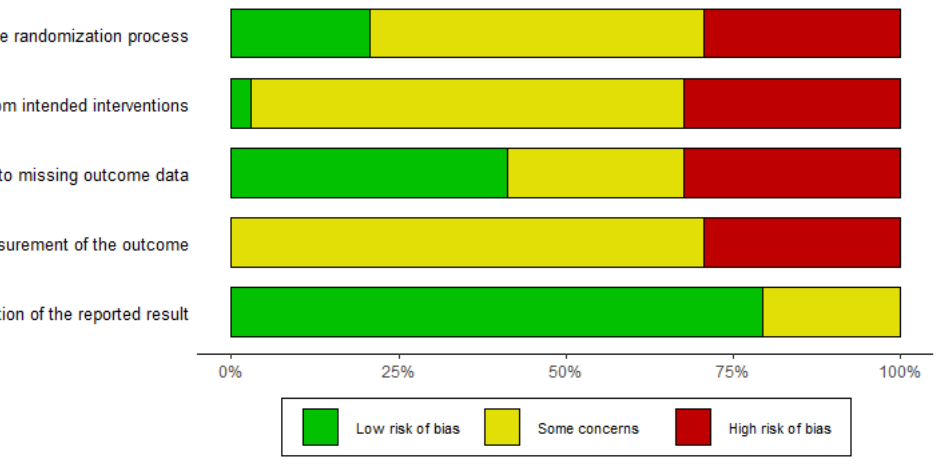
Figure 2. Results of risk of bias assessments according to RoB 2 Risk of Bias Tool [15].